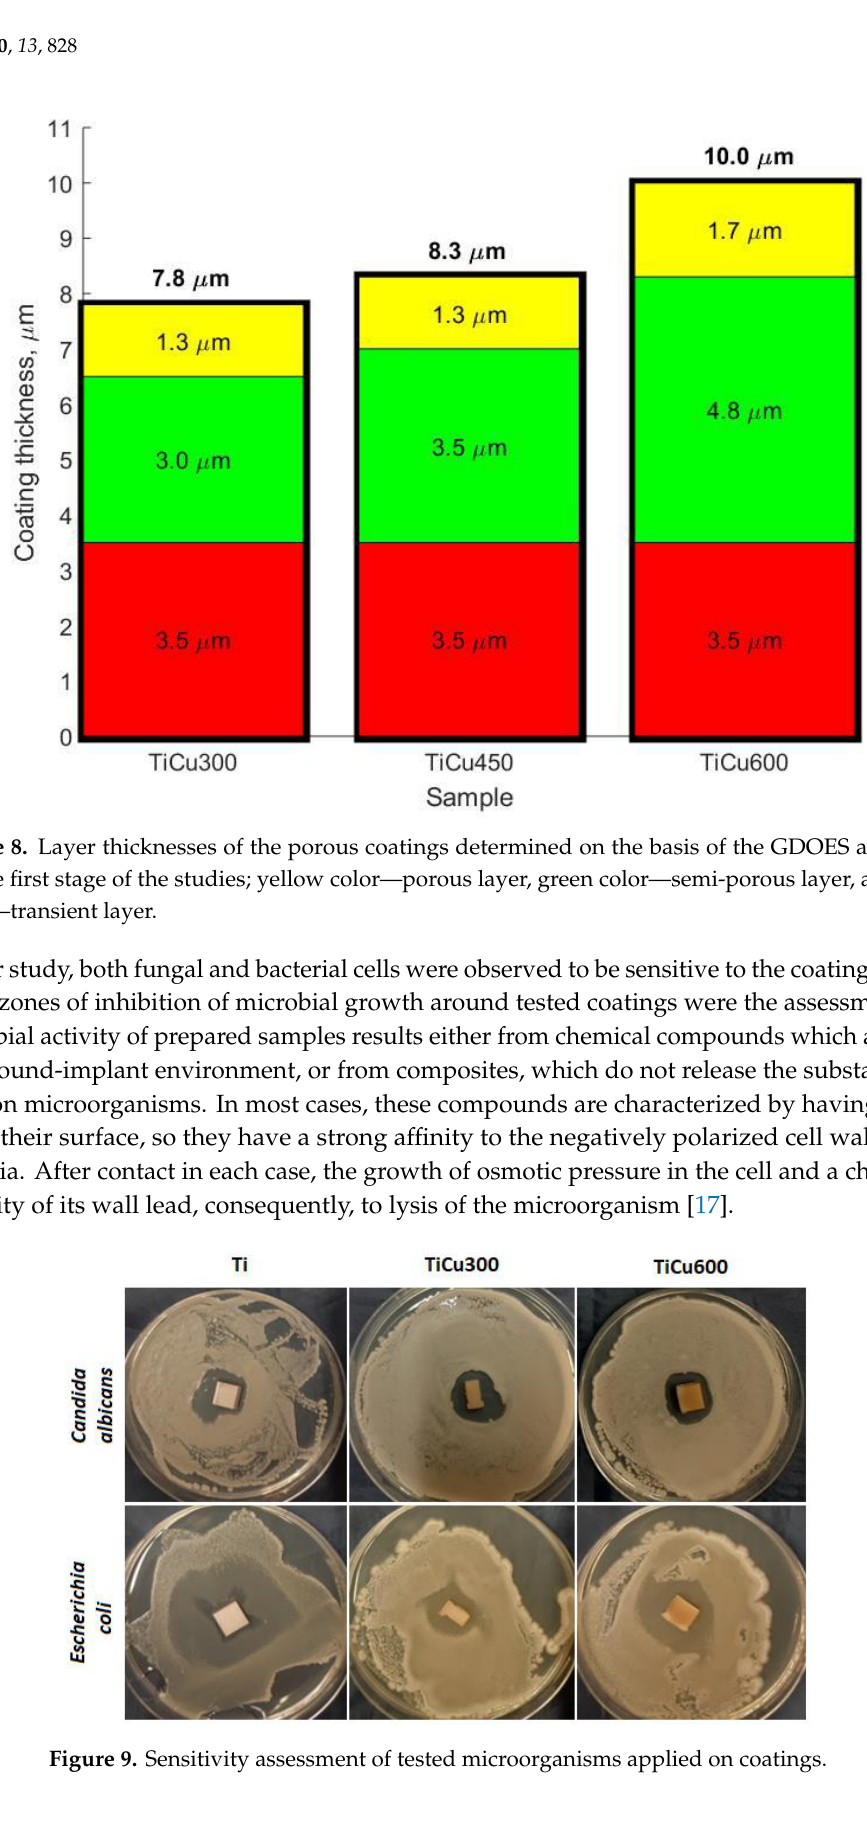
Figure 10. Example fields of adhered cells to reference sample (titanium) and fabricated coatings.